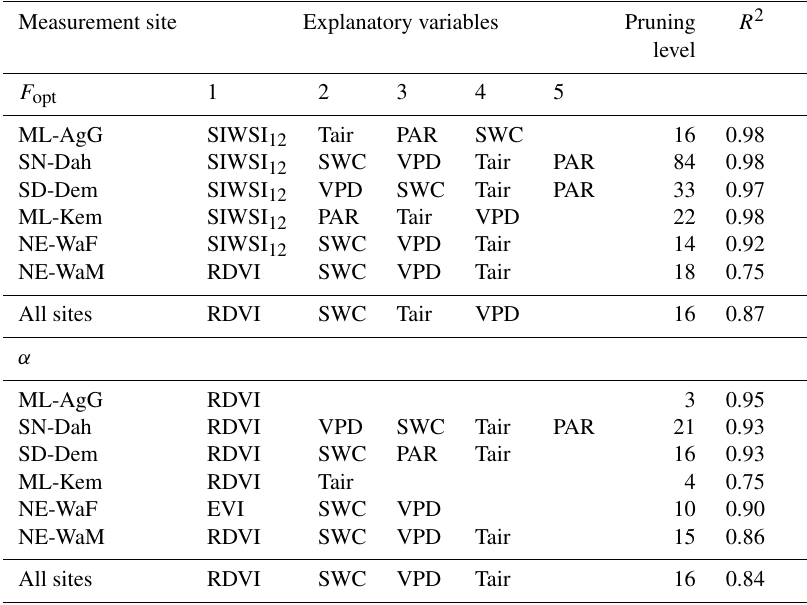
Table 3. Statistics for the regression tree analysis. Regression tree analysis was used to study relationships between intra-annual dynamics in photosynthetic capacity ( F opt ; F opt_frac for all sites) and quantum efficiency ( α ; α _frac for all sites) and explanatory variables. The pruning level is the number of splits of the regression tree and an indication of complexity of the